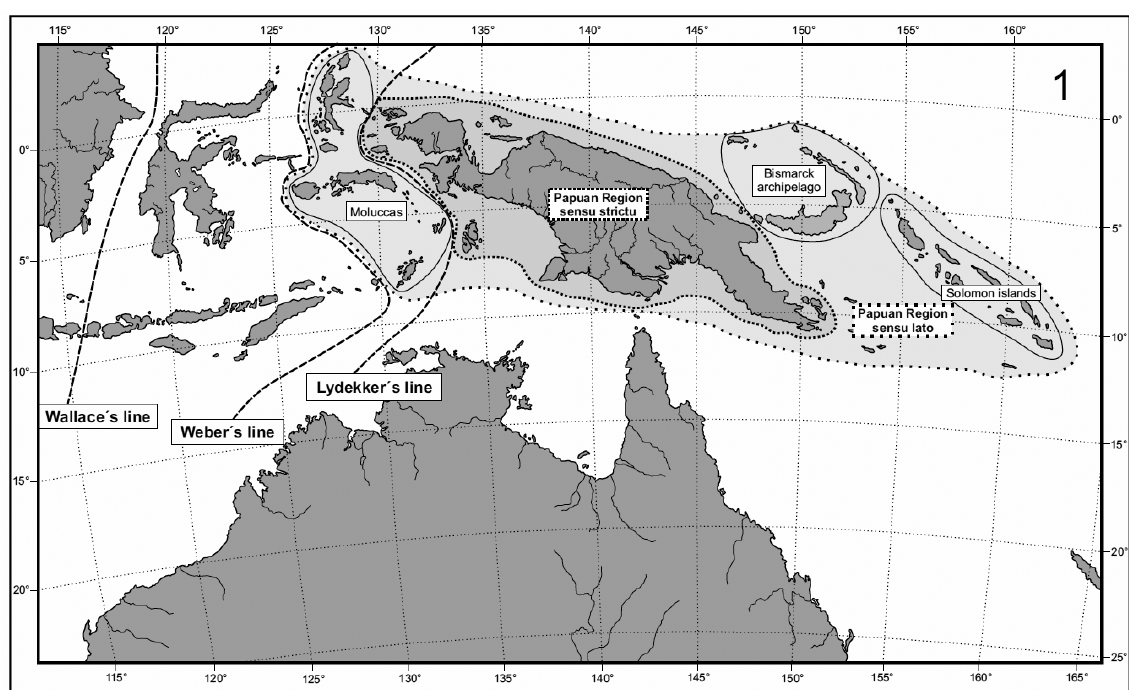
Fig. 1. Map of the study area. All island groups east of Wallace’s Line towards the Solomon Islands are considered. The Papuan Region sensu stricto is shaded dark grey, sensu lato is pale grey. Major lines of biogeographical importance are